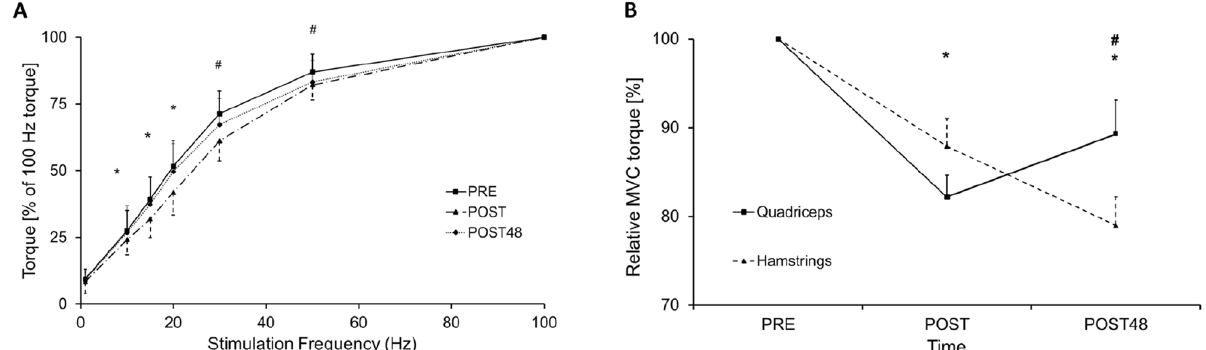
Figure 2. ( A ) Torque-frequency relationship, all frequencies were normalised to 100 Hz. *Significant differences between before (PRE) and immediadtely after (POST) the repeated maximal sprint intervention, P < 0.05; # significant differences between PRE and POST, and between PRE and POST48, P < 0.05. Data are presented as mean ± SEM. ( B ) Comparison of relative maximal voluntary contraction (MVC) loss between hamstring and quadriceps muscle group before (PRE), immediately after (POST) and 48 h after (POST48) the repeated maximal sprint intervention. *Signifcant differences compared to PRE, P < 0.001; # significant differences between quadriceps and hamstring MVC, P < 0.05. Data are expressed as mean ± SEM. This figure was produced in Microsoft Excel